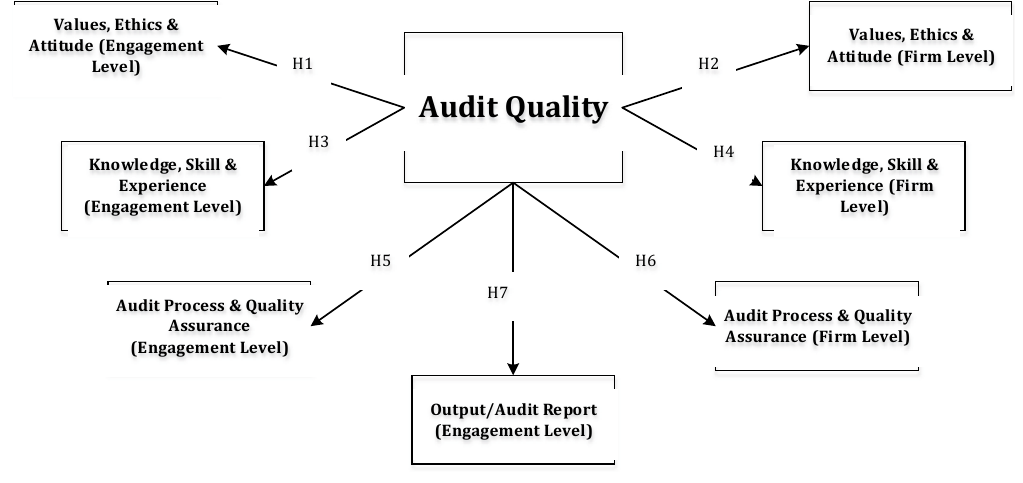
Fig. 1. Conceptual Framework